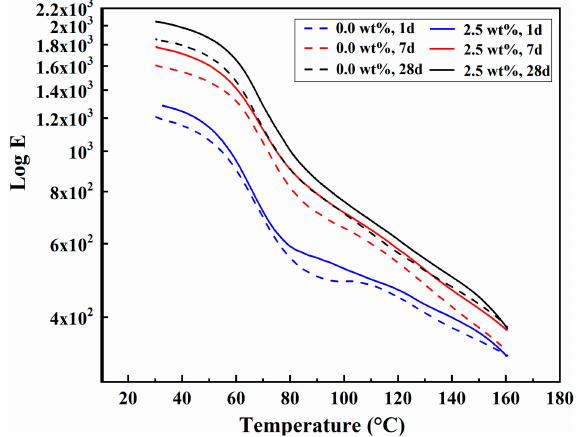
Figure 9. The relationship between storage modulus and temperature of PU, PU / MFA-0.0 wt. %, and PU / MFA-2.5 wt. % specimens at di ff erent curing